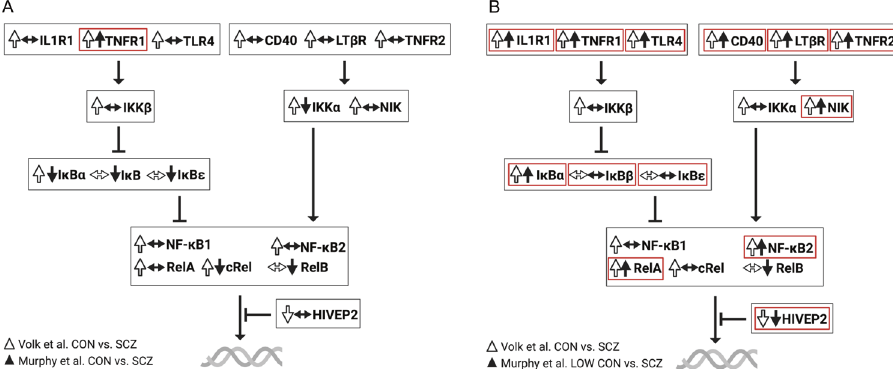
Fig. 2 Expression of NF- κ B transcripts in the DLPFC of controls vs. schizophrenia. Two studies have measured NF- κ B pathway transcripts in the DLPFC of people with schizophrenia compared to unaffected, age-matched controls. A Volk et al. [11] report up-regulations at multiple levels of the pathway in schizophrenia while Murphy et al. [12] replicated only one of these fi ndings (TNFR1) and found several down- regulations of the same NF- κ B pathway transcripts in schizophrenia. B When high in fl ammation controls (individuals with elevated levels of pro-in fl ammatory mRNAs) were omitted from analyses in Murphy et al. [12], many (13 of 18) of the diagnostic comparisons in NF- κ B pathway transcripts were consistent with those reported by Volk et al. [11]. Red boxes indicate shared fi ndings between both